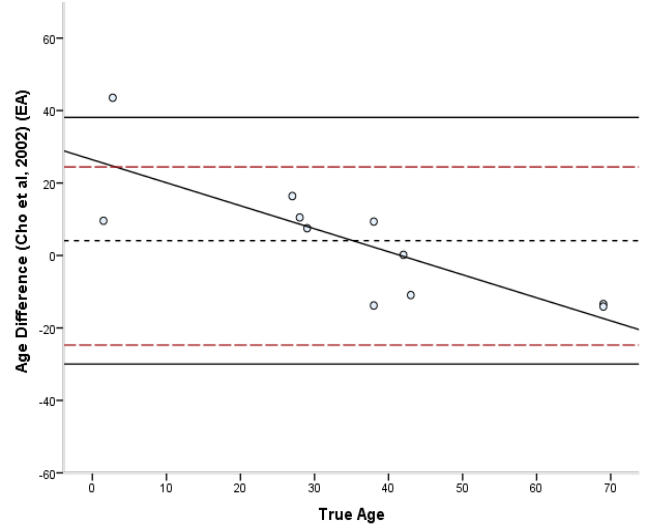
Figure 4. Bland–Altman plot for Cho’s et al. [7] method illustrating the differences between known and estimated ages for the ribs against the known age. Depicted are 95% limits of agreement (black horizontal lines), mean difference/bias (black dotted line), best fit lines and 95% confidence intervals of the SEE for each method (dashed lines). R 2 of the best fit line: 0.636.